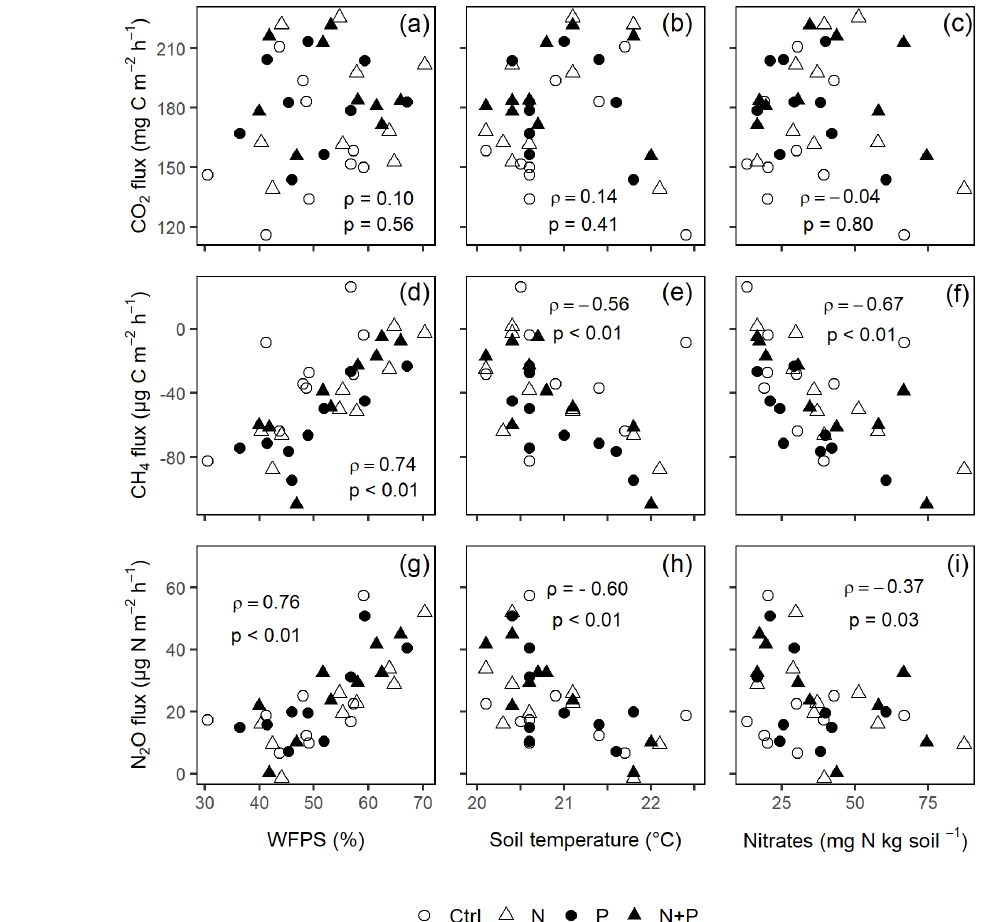
Figure 6. The Spearman correlation coefficient between mean background CO 2 (a–c) , CH 4 (d–f) , and N 2 O (g–i) fluxes and WFPS (column 1), soil temperature (column 2), and nitrates (column 3) using monthly measurement means of four replicate treatment plots (i.e., control (Ctrl), nitrogen (N), phosphorus (P), and N + P) taken between May 2019 and June 2020 ( p ≤ 0 . 05; n = 16; i.e., four replicate plots in each of the four treatments). ρ is Spearman’s correlation